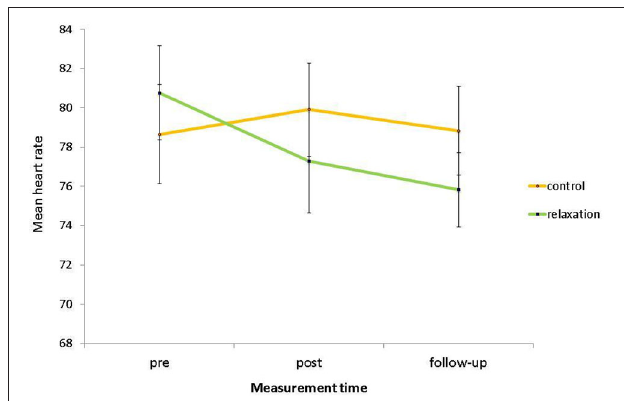
FIGURE 2 | Mean heart rate, i.e., baseline assessment (pre), after the intervention (post), and after the PM task (follow-up) as a function of relaxation condition. Bars represent standard errors.